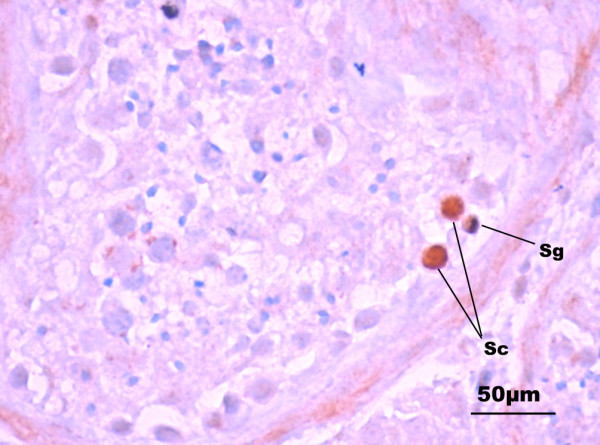
HCMV detection in male germ cells on Day 14 post infection in testis organotypic culture. Immunoreactivity with monoclonal antibodies specific to HCMV pp65 protein is shown on section of infected testis explants in organotypic culture on Day 14 post infection. Spermatogonia (sg) and spermatocytes (sc) are found to contain viral antigen.